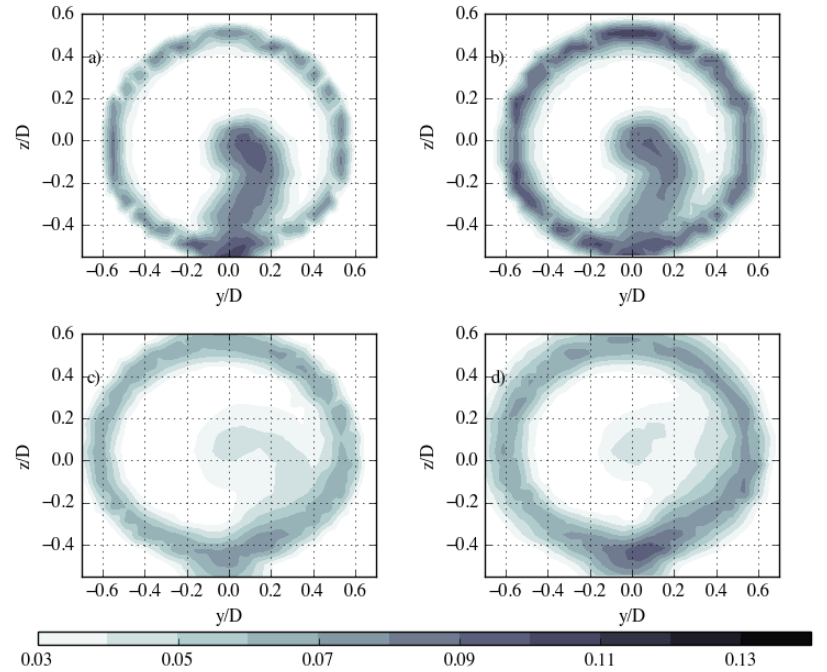
Figure 13. Experimental maps of the normalised streamwise velocity standard deviation at x / D = 1 ( a , b ) and x / D = 3 ( c , d ) for the balanced rotor ( left column ) and + 5 ◦ unbalanced rotor ( right column ).